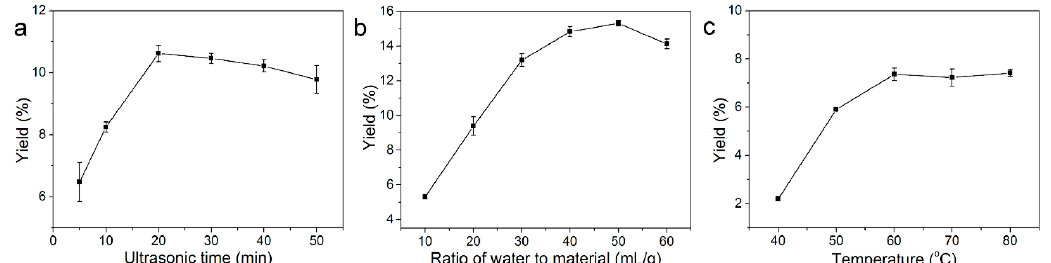
Figure 1. Effect of different extraction factors (( a ) ultrasound exposure time, min; ( b ) ratio of water to material, mL/g; ( c ) ultrasound extraction temperature, °C) on the extraction yield of PRM. The effects of ultrasound exposure time, ratio of water to material and ultrasound extraction temperature were first studied by a single-factor design as follows: only one factor was changed while the other factors were kept constant in each independent experiment. The effect of each factor was evaluated by determining their yield of PRM.